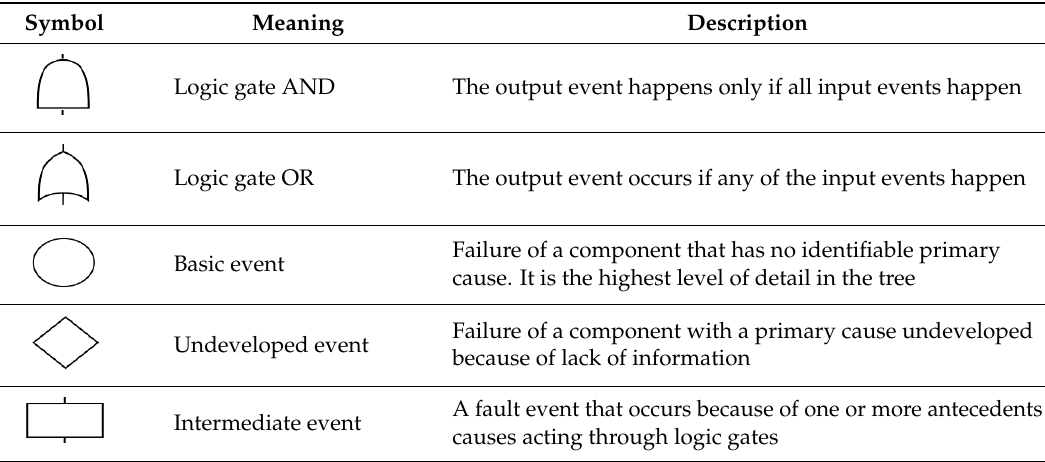
Table 2. Symbols used in fault trees. Source: ISO 31.010:2011 [27] and Vesely et al. [37].